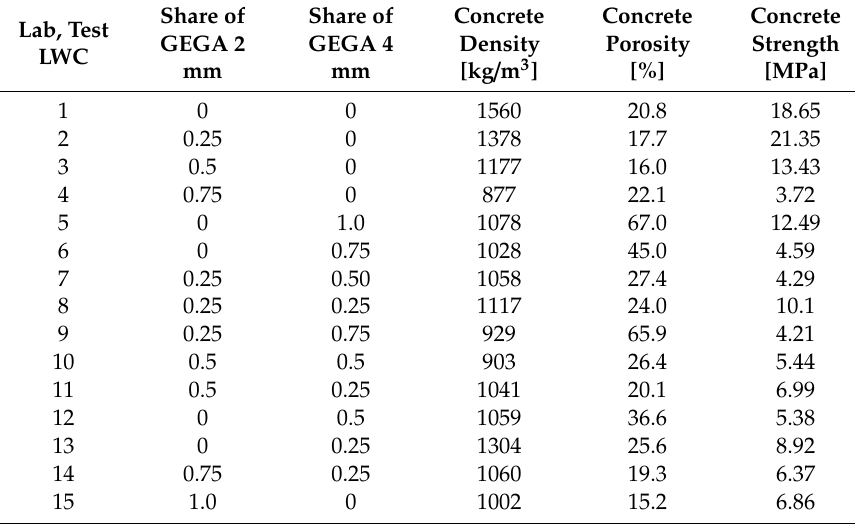
Table 6. Results of laboratory tests.